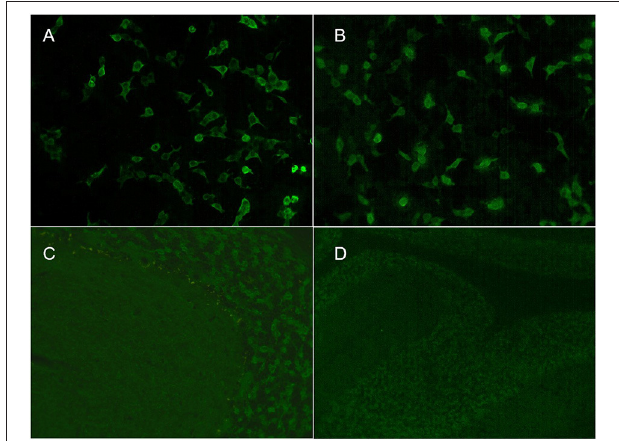
FIGURE 2 | Indirect immunofluorescence assays of serum and cerebrospinal fluid (CSF) in patient 3. Cell-based assays of serum (A) and CSF (B) were both positive. Tissue-based assays of serum (C) and CSF (D) were both positive.